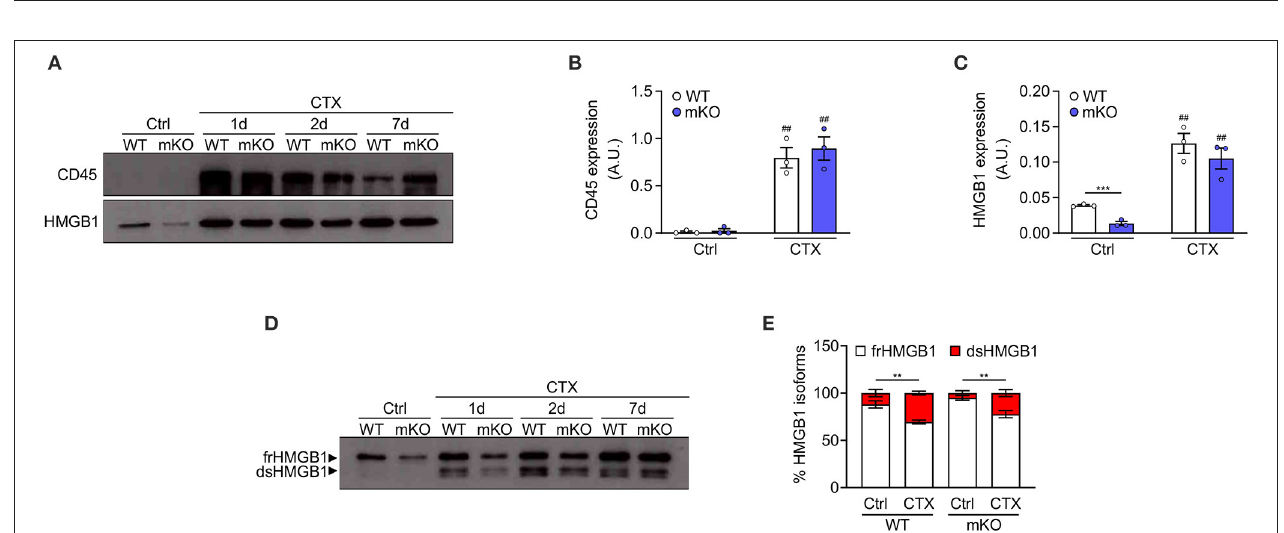
FIGURE 1 | total HMGB1 protein expression levels, relative to control (Ctrl) and normalized on Ponceau staining, at indicated time points after CTX injection. A.U. = arbitrary unit ( n ≥ 10 muscles, 3 mice/time point). (D) Quantification of CD45 and HMGB1 redox isoforms expression (frHMGB1 and dsHMGB1), normalized on Ponceau staining, at indicated time points. (E) Distribution of HMGB1 redox isoforms expression in muscle lysates in absence (controls and at 1h post-injury) or presence of CD45-positive cells (from 6h to day 7 post-injury). (F–I) Western blot probed with anti-HMGB1 antibody in reducing (upper panel) and non-reducing conditions (lower panel) on supernatant of muscles isolated at indicated time points after CTX injection (F) . Total HMGB1 protein expression at indicated time points after CTX injection (G) . A.U. = arbitrary unit ( n = 6 muscle supernatants, 3 mice/time point). (H) Quantification of HMGB1 redox isoforms expression (frHMGB1 and dsHMGB1) in muscle supernatants, from Western blot assays in non-reducing conditions, at indicated time points after CTX injection and compared with CD45 expression as in (D) . (I) Distribution of HMGB1 redox isoforms expression in supernatants of muscle in absence (controls and at 1h post-injury) or presence of CD45-positive cells (from 6h to day 7 post-injury). Data represent the means ± SEM and statistical significance was calculated by One-way (C,D,G,H) and Two-way ANOVA (E,I) . * P < 0.05; ** P < 0.01; *** P < 0.001; **** P < 0.0001.